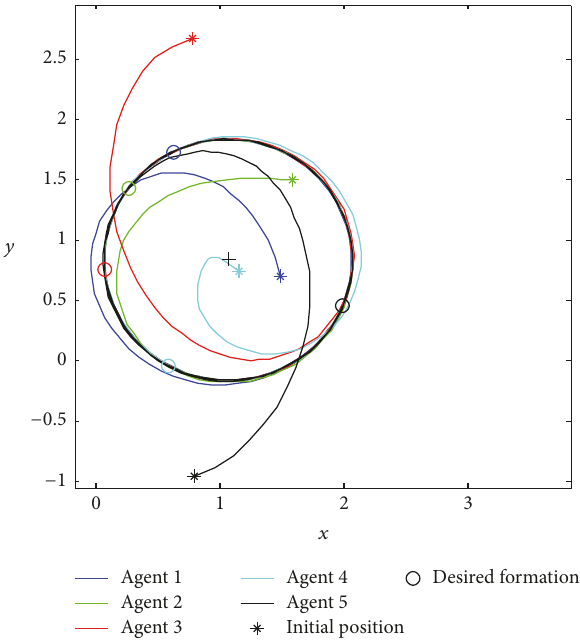
Figure 5: Circular formation trajectories 𝑝 𝑘 (𝑡) with center